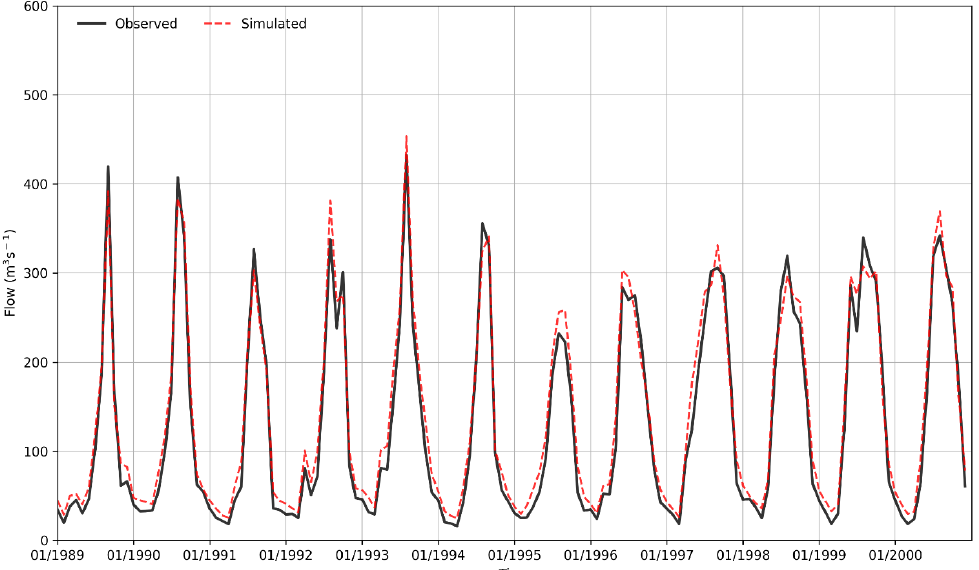
Figure 8. Monthly observed and simulated streamflow for the calibration period (1989 – 2000).